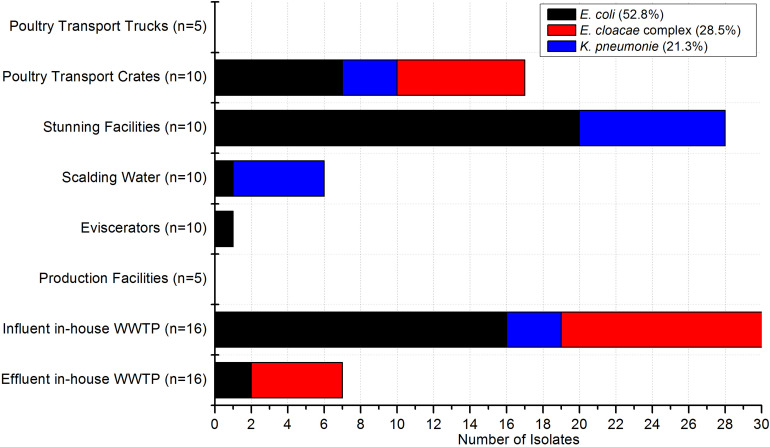
Occurrence of target bacteria tested as colistin-resistant across the sampling points in poultry slaughterhouses (n = 82). Number of samples taken at each sampling point is stated.